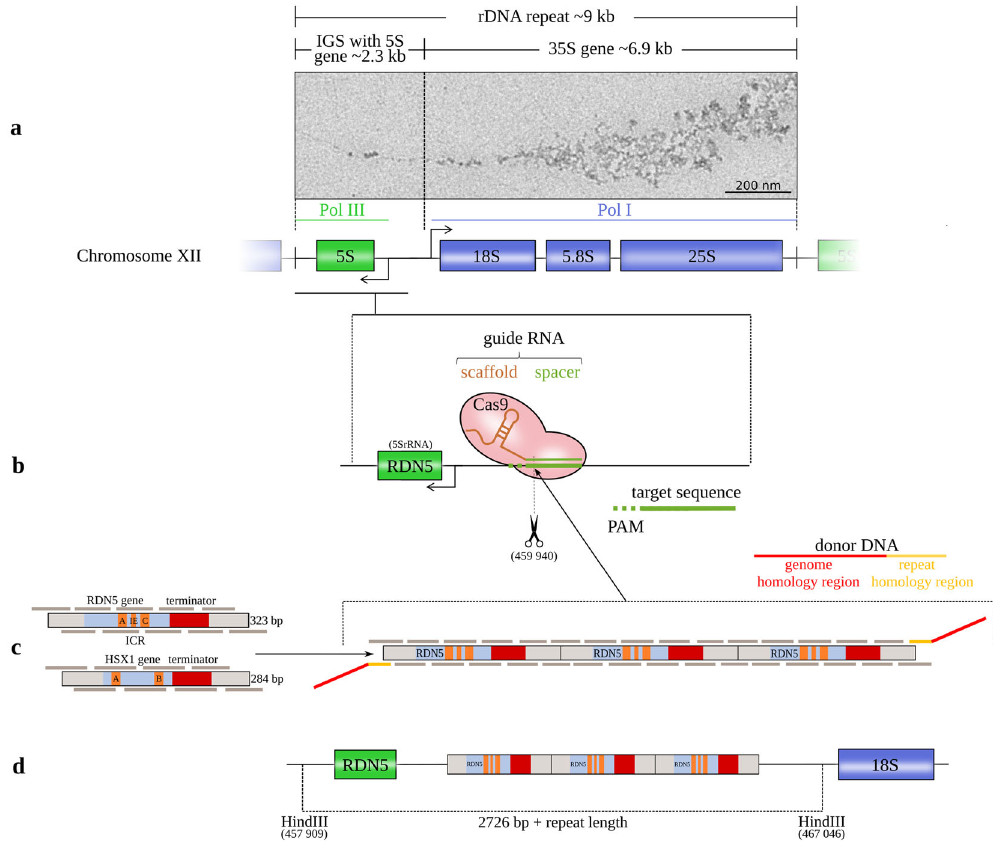
Fig. 1 Schematic of the method for introducing gene copies. a The rRNA repeats on S. cerevisiae chromosome XII with the 18S, 5.8S, and 25S rRNAs (transcribed by the RNA polymerase I (Pol I)) and the 5S rRNA (transcribed by Pol III in the reverse direction from the complementary strand). The 5S rRNA gene is located in the intergenic spacer (IGS) between successive repeats (Saccharomyces Genome Database standard name: RDN5-1 ). EM image: Miller tree in chromatin spreads of S. cerevisiae strain IMX672 at 12,000× magni fi cation from positively stained sample. b The CRISPR/Cas9 system induces a double-strand break at the chosen target site with a protospacer adjacent motif (PAM) downstream of the RDN5 gene (5 S rRNA) within the rRNA repeat. c Both copy units cover the gene sequence, the terminator and a 50 bp spacer on both sides. RDN5 is a type 1 promoter gene with an internal control region (ICR) that contains box A and box C elements and an intermediate element (IE). The internal promoter requires the transcription factors IIIC, IIIB, and IIIA (TFIIIC, TFIIIB, and TFIIIA). HSX1 is a type 2 promoter gene with box A and box B elements that requires only TFIIIC and TFIIIB 8 . The copy units are divided into overlapping oligomers. The in vivo repeat assembly is targeted to the Cas9 cleavage site by donor DNA adapters. d After Cas9 cleavage, the copy cluster is inserted at the DSB